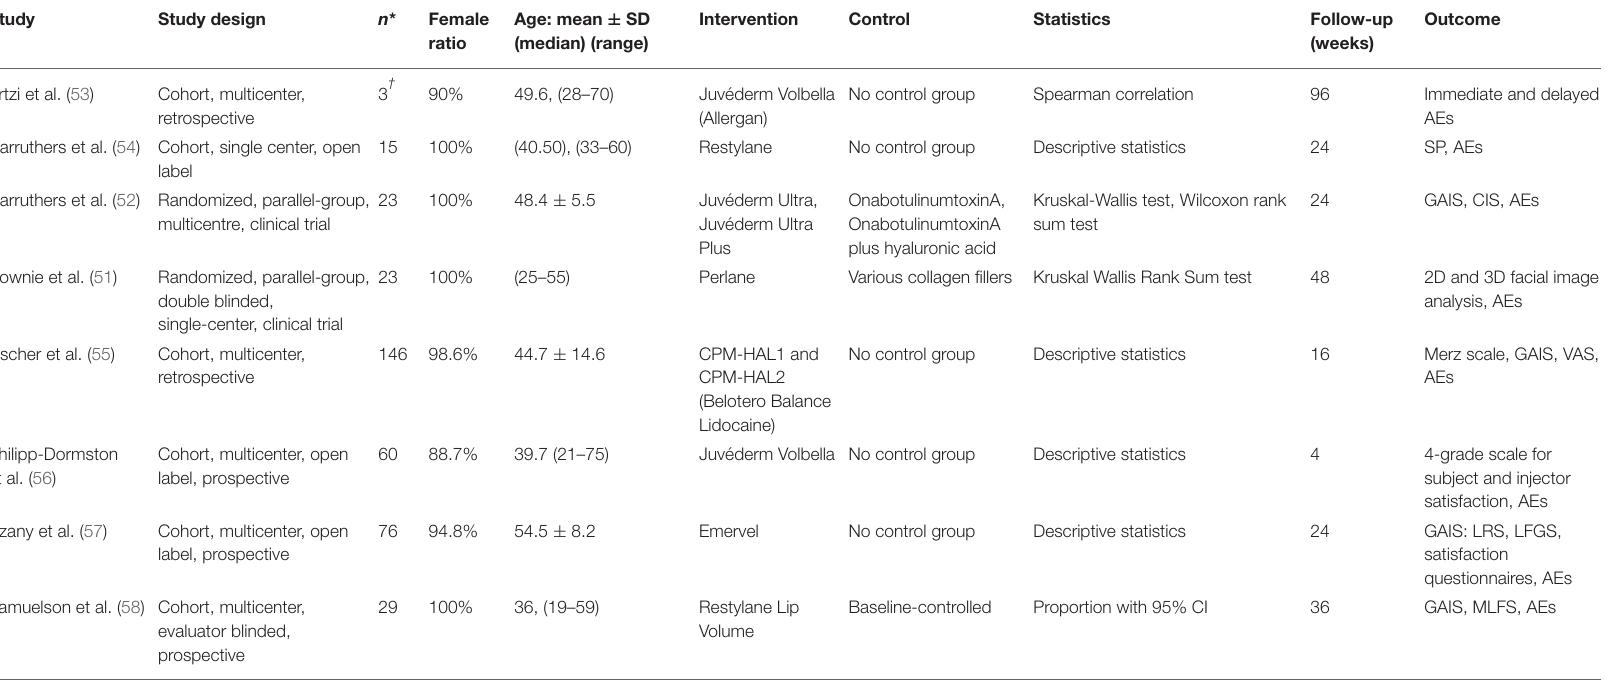
TABLE 2 | Study characteristics of RCTs and cohort studies only included in adverse effect